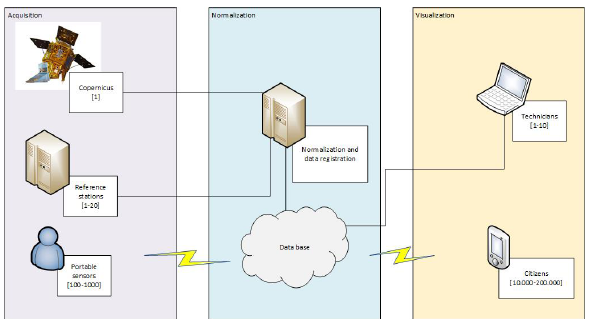
Figure 2. Architecture of the Crowd-sourced Air Quality Monitoring System.